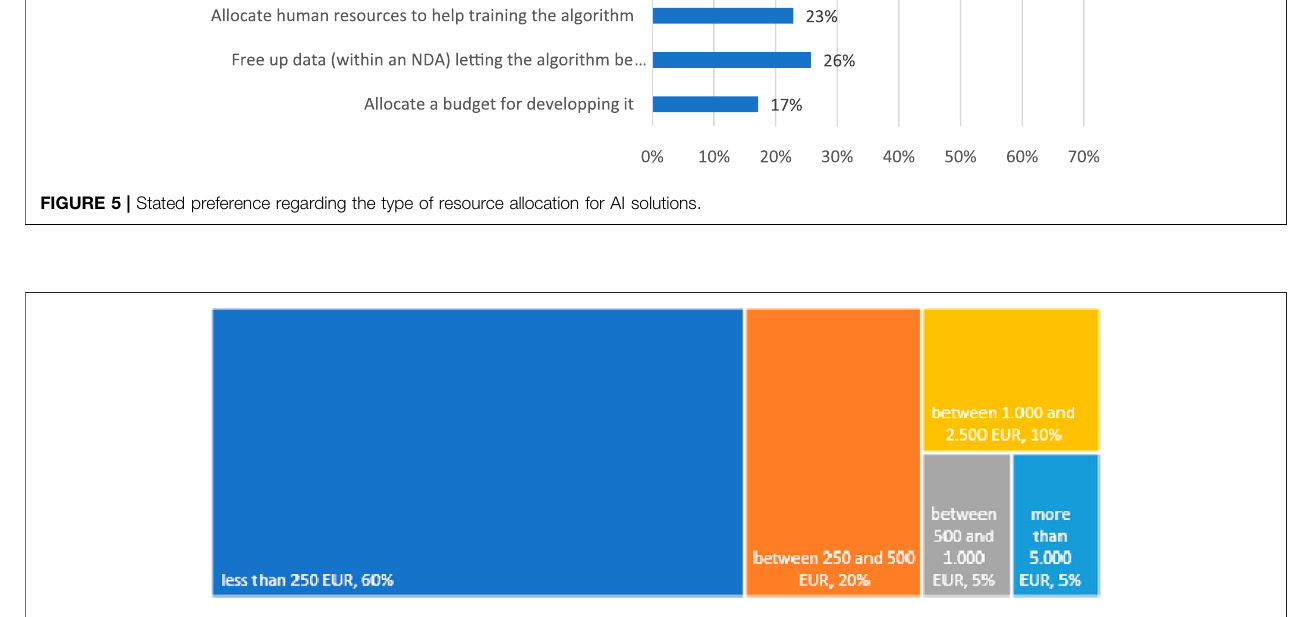
FIGURE 6 | Stated preference regarding the monthly willingness to pay for AI service to support data entry tasks.